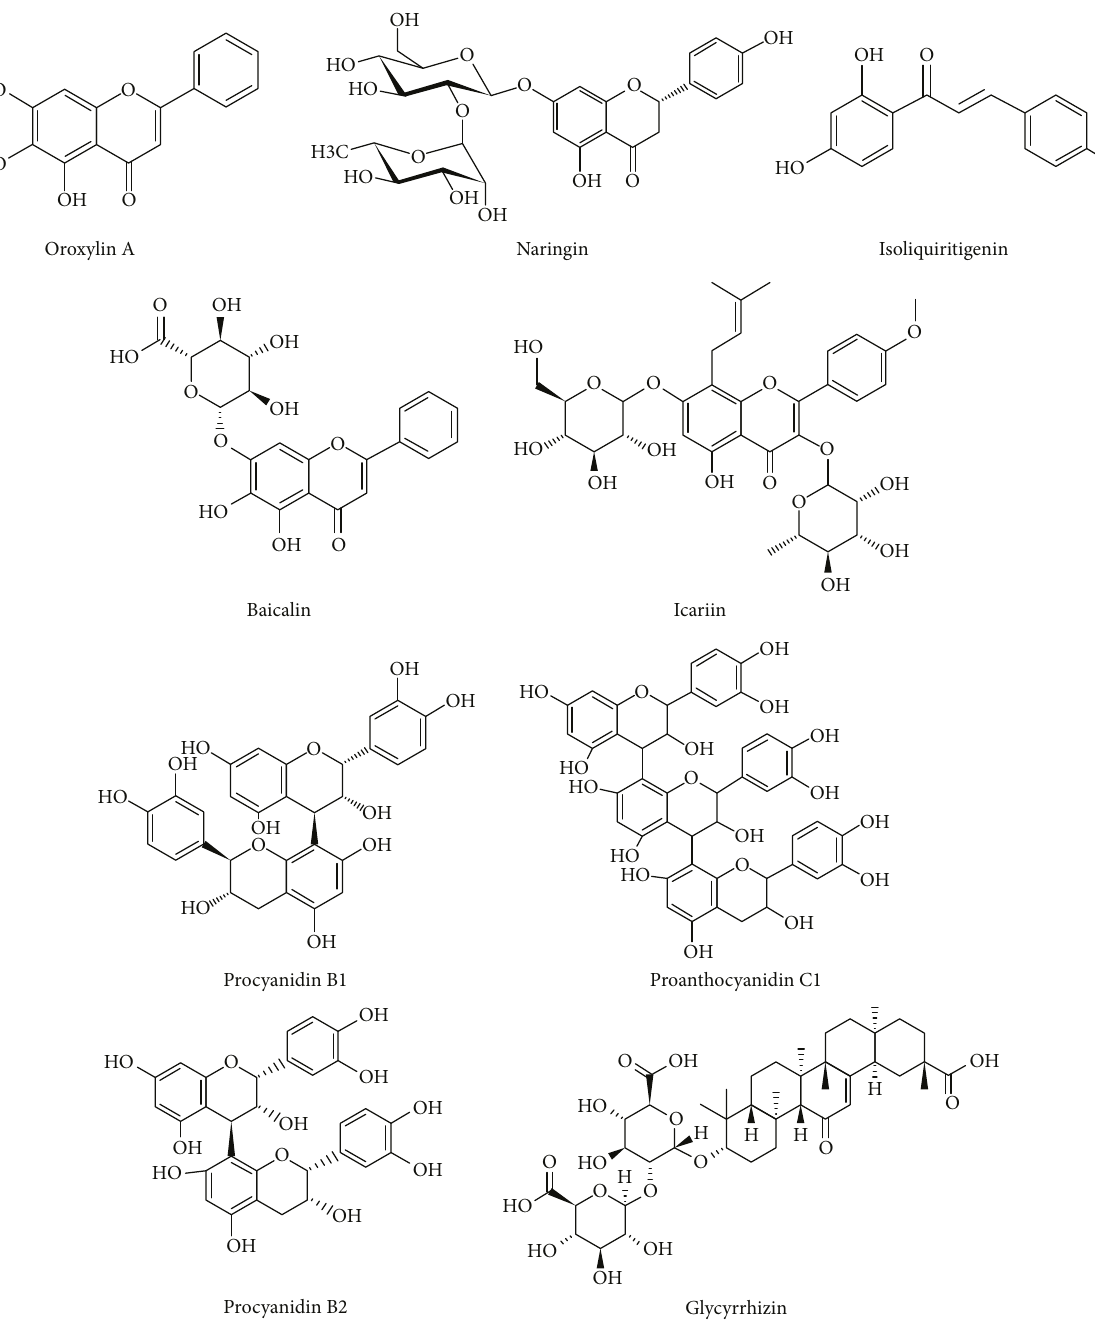
Figure 1: Chemical structures of principal fl avonoids discussed in relation to their role on Th17 in rheumatoid arthritis and its experimental